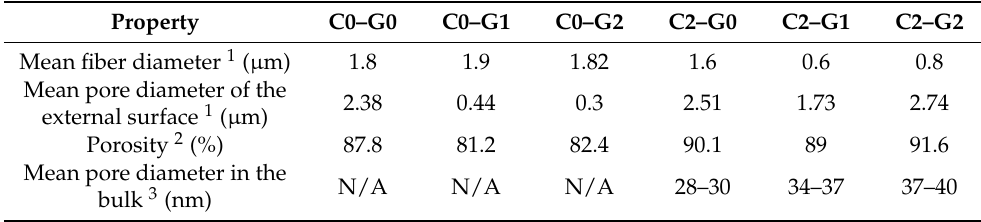
Figure 2. SEM micrographs at different magnifications of C0–G0 ( a – a” ), C0–G1 ( b – b” ), C0–G2 ( c – c” ). Arrows indicate the peculiar morphologies imparted by nanoparticles. Table 2. Characterization of the fibrous architecture of the mats.